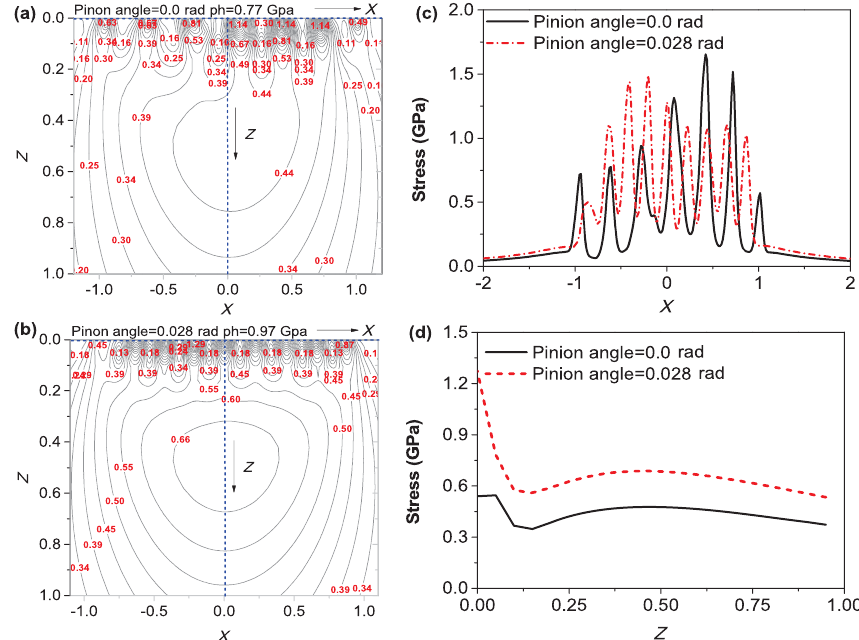
Fig. 14 Octahedral stress at the pinion angle of 0.0 and 0.028 rad (no